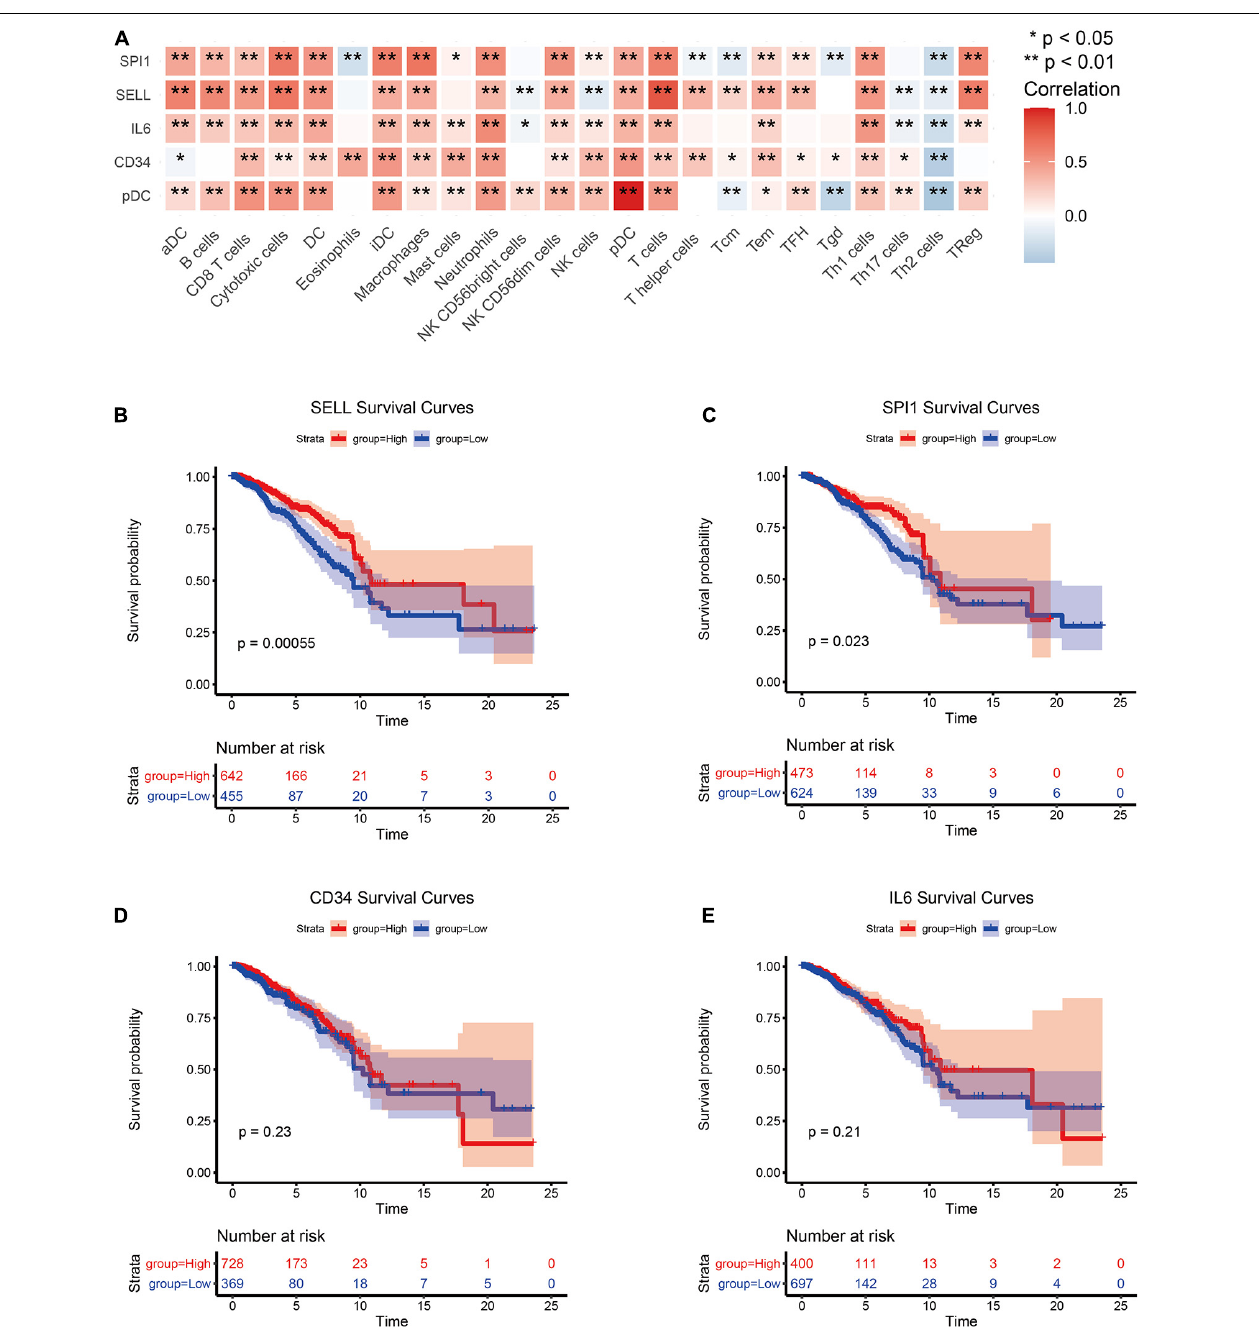
FIGURE 4 | Screening of hub genes and correlation analysis. (A) Correlation analysis between hub genes and TIICs. (B–E) Survival analysis of hub